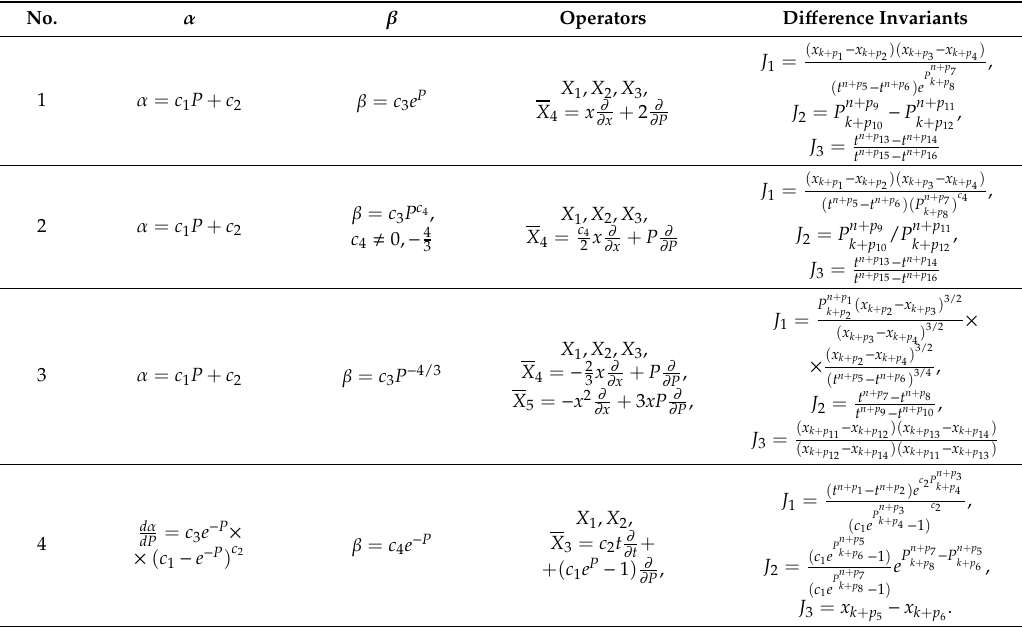
Table 1. Invariant di ff erence schemes for gas flow